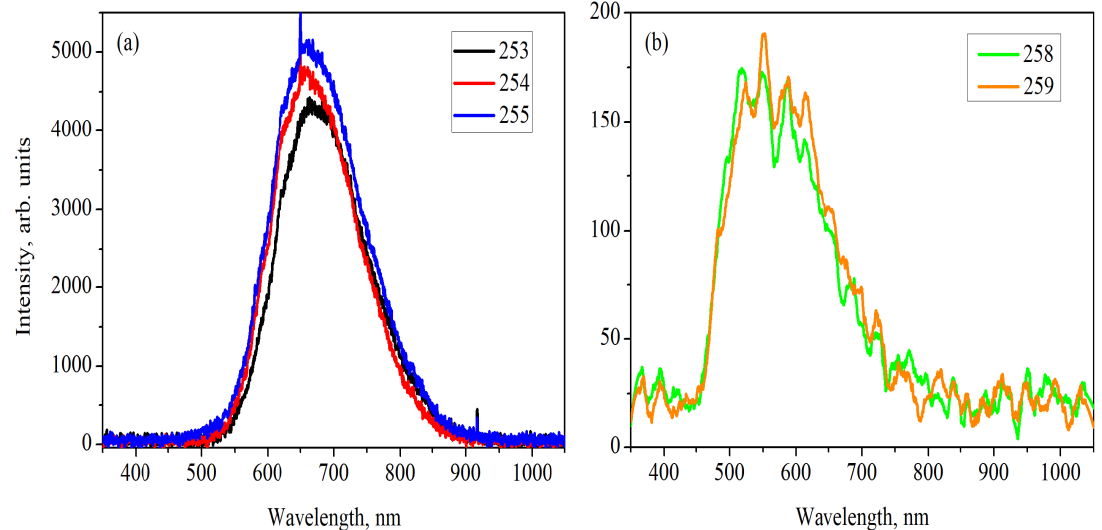
Figure 5. Photoluminescence spectra of porous silicon samples ( a ) No. 253–255 and ( b ) No. 258–259.